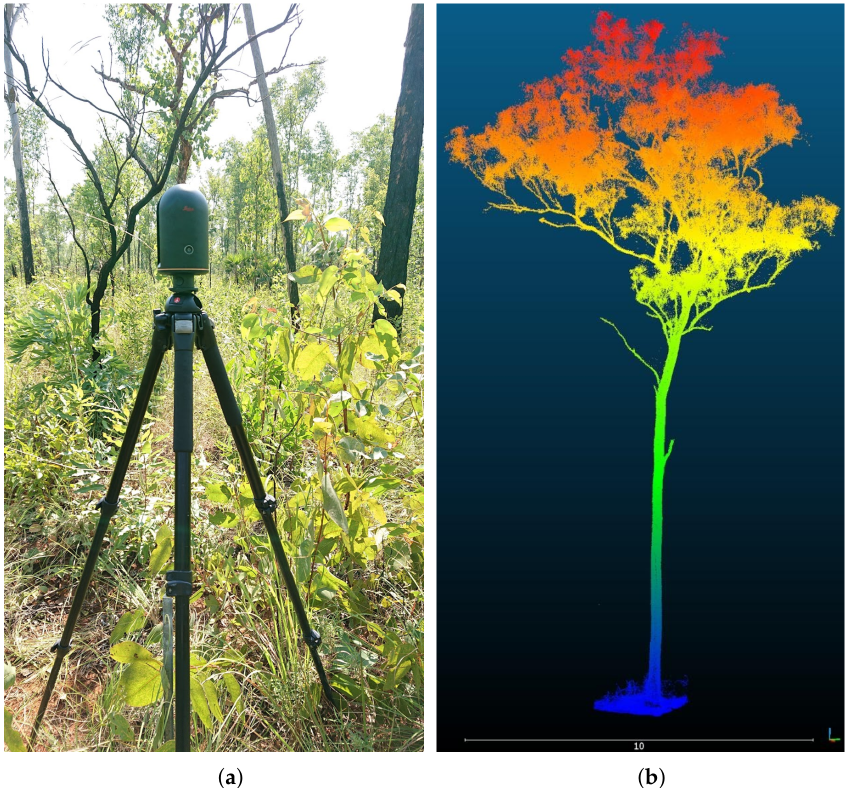
Figure 2. ( a ) Leica BLK360 set up within the study area; ( b ) Eucalyptus tetrodonta sub-sampled to 2 points cm − 2 , point size 1. The crown is irregularly shaped with evidence of storm and/or fire